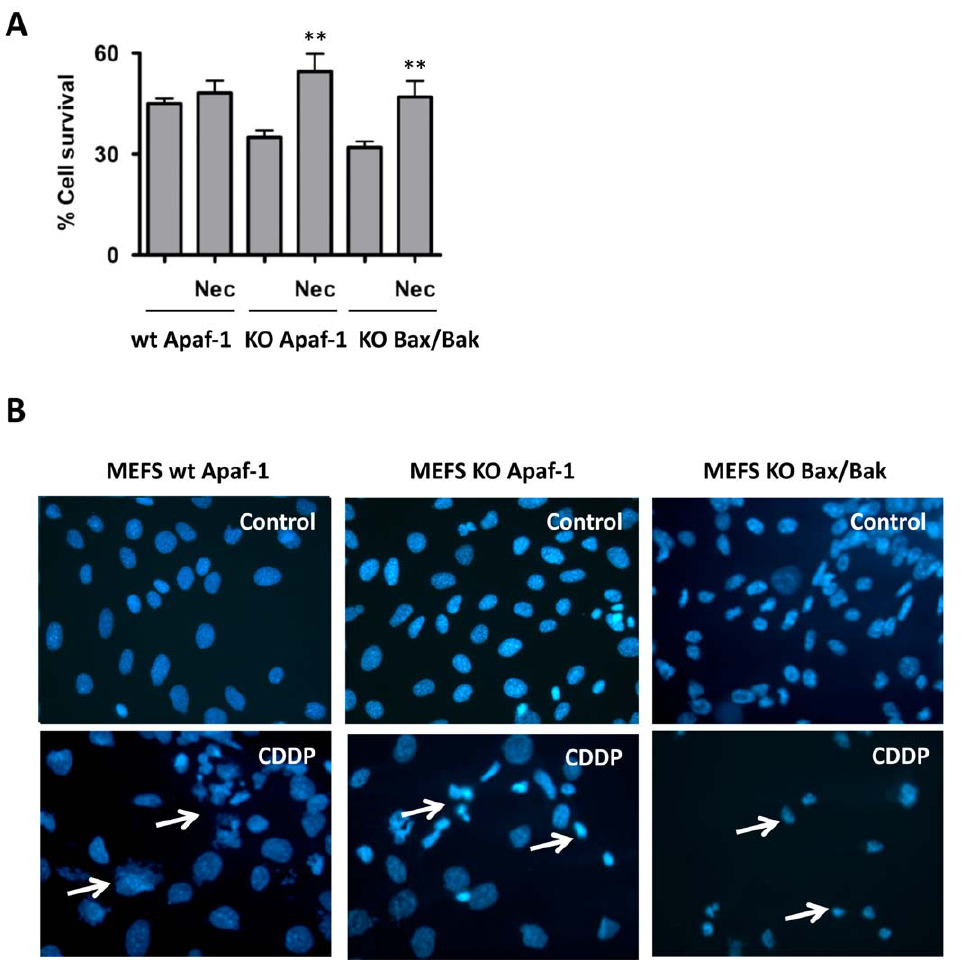
Figure 3. Non apoptotic cell death upon CDDP treatment in Apaf-1- and Bax/Bak-deficient cells. ( A ) Cell survival was measured by trypan blue exclusion upon treatment with CDDP (30 m M) in the presence or absence of necrostatin (Nec; 100 m M). Bars represent the mean of three experiments 6 s.d. (** p , 0.05). ( B ) MEFS wt Apaf-1, MEFS KO Apaf-1 and MEFS KO Bax/Bak were stained with DAPI upon CDDP (30 m M) treatment. Nuclei are considered to have the normal phenotype when glowing bright and homogenously. Apoptotic nuclei can be identified by the fragmented morphology of nuclear bodies. White arrows indicate dying cells.